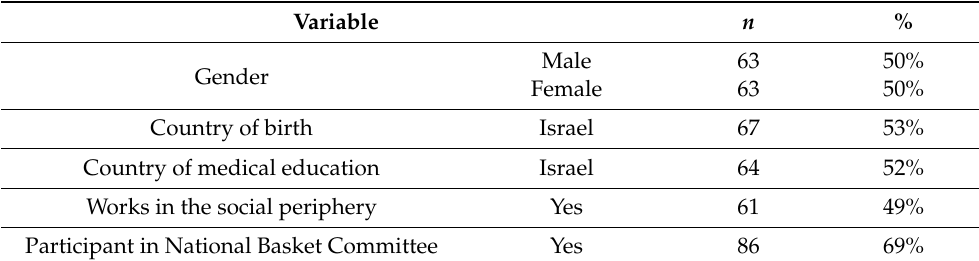
Table 2. Characteristics of survey sample.